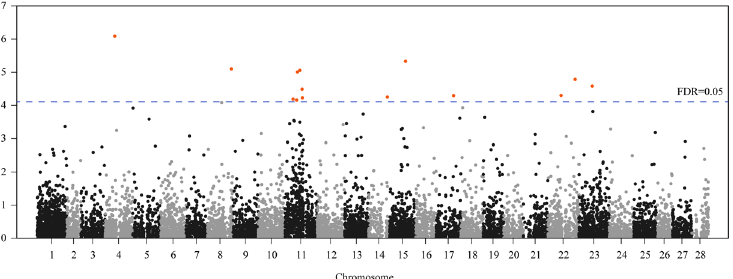
Figure 2. Genome wide linkage analysis based on SNP_index. Blue line shows the significance threshold (FDR = 0.05); the linked markers are highlighted in red.